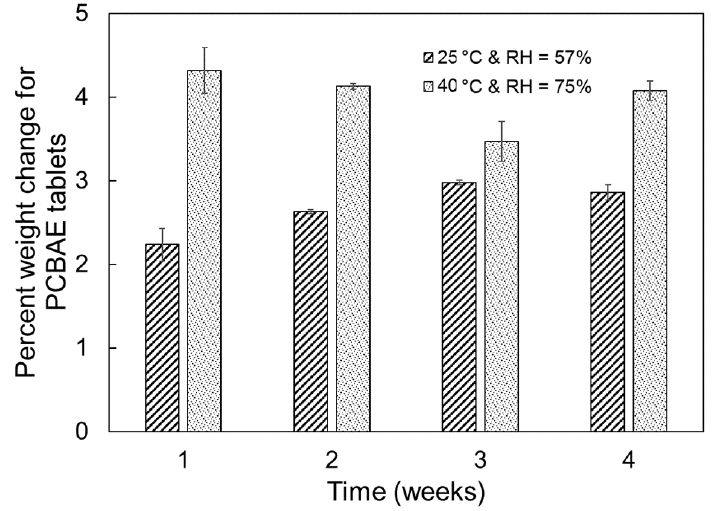
Figure 5. PCBAE prodrug tablet moisture absorption as a function of storage time for standard and accelerated storage conditions. Percent weight change from T0 (initial) tablet weight.